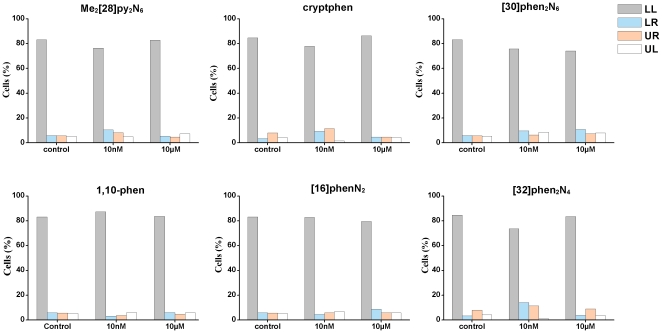
Relative percentages of viable cells (LL), early apoptotic cells (LR), necrotic cells (UL) and late apoptotic cells (UR) induced by Me2[28]py2N6, [32]phen2N4, cryptphen, [16]phenN2, [30]phen2N6 and 1,10-phen in NHDF cells.The cells have been treated with concentrations 10 nM and 10 µM of each compound for 48 h and comparing with the control.